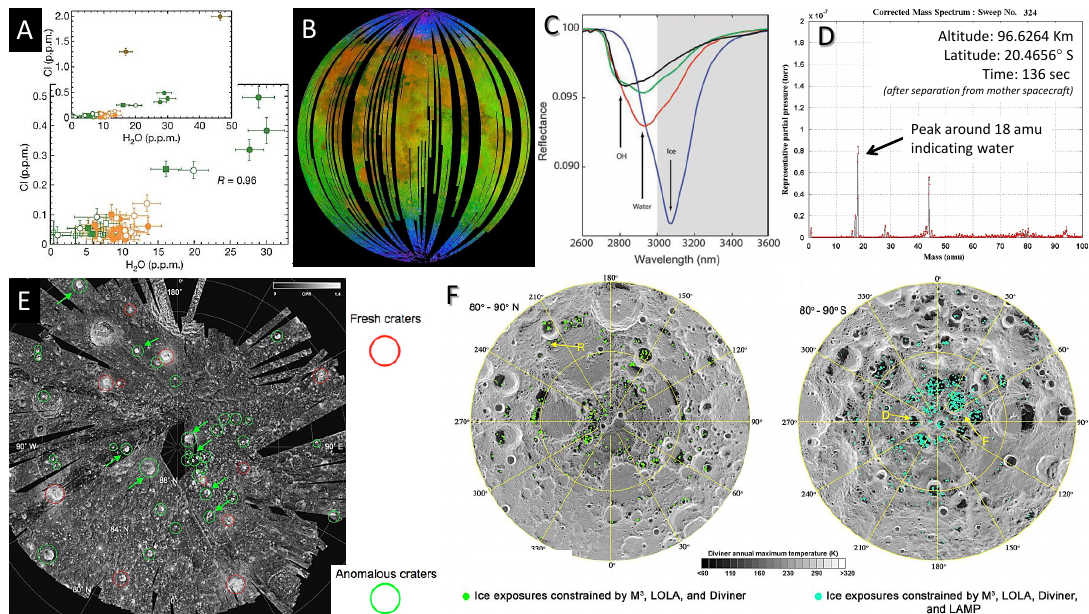
Figure 5. Discovery of three different flavors of volatiles on the Moon. ( A ) Water (and other volatiles) in the lunar interior, measured directly in lunar samples (Source: [68]) . ( B ) OH/H 2 O on the lunar surface measured by remote sensing (Source: [NASA]) . ( C ) Near infrared signatures of OH, H 2 O and Ice (Source: [82]) . ( D ) In-situ detection of surficial water on the Moon. The distinct peak at mass no. 18 has been interpreted to be signature of water (Source: Modified from [84]) . Water-ice signatures on the lunar poles detected at ( E ) radar wavelengths (Source: Modified from [89]) and ( F ) integrated datasets including near-infrared, thermal wavelengths (Source: [99])